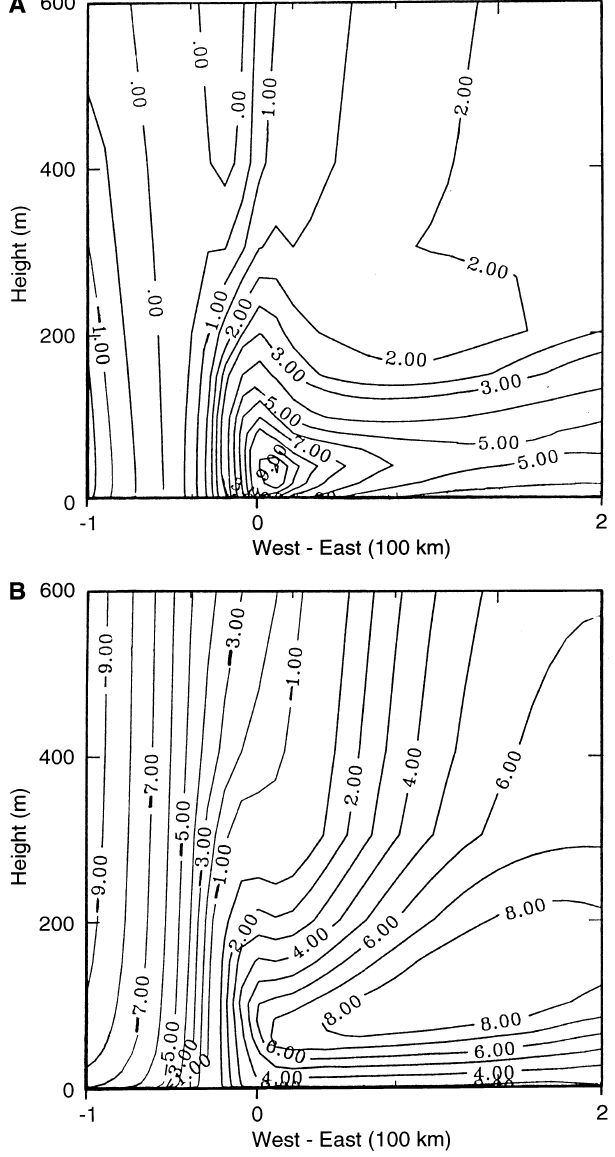
Fig. 15A,B. As in Fig. 6 but for simulation ( S